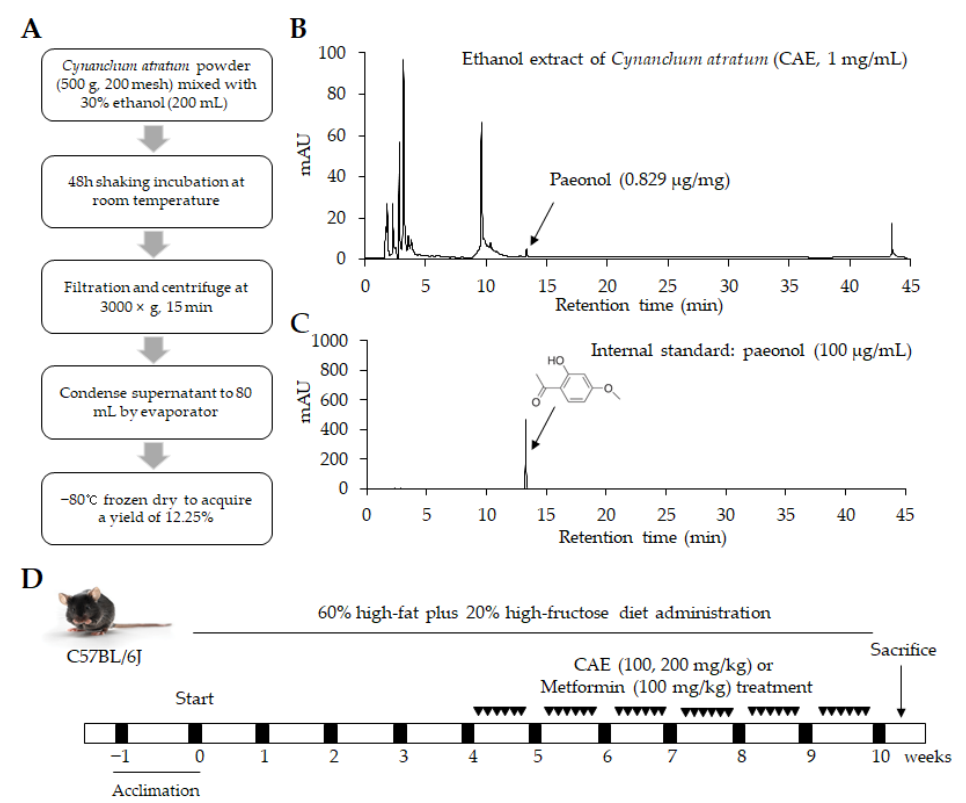
Figure 1. Herbal extract and design of the animal study. ( A ) The brief procedure of Cynanchum atratum extraction (CAE). HPLC-based fingerprinting of ( B ) 30% ethanol extract of Cynanchum atratum (CAE) and ( C ) paeonol (internal standard) were determined at a wavelength of 300 nm. A synthetic scheme presents the information regarding experimental design ( D ).